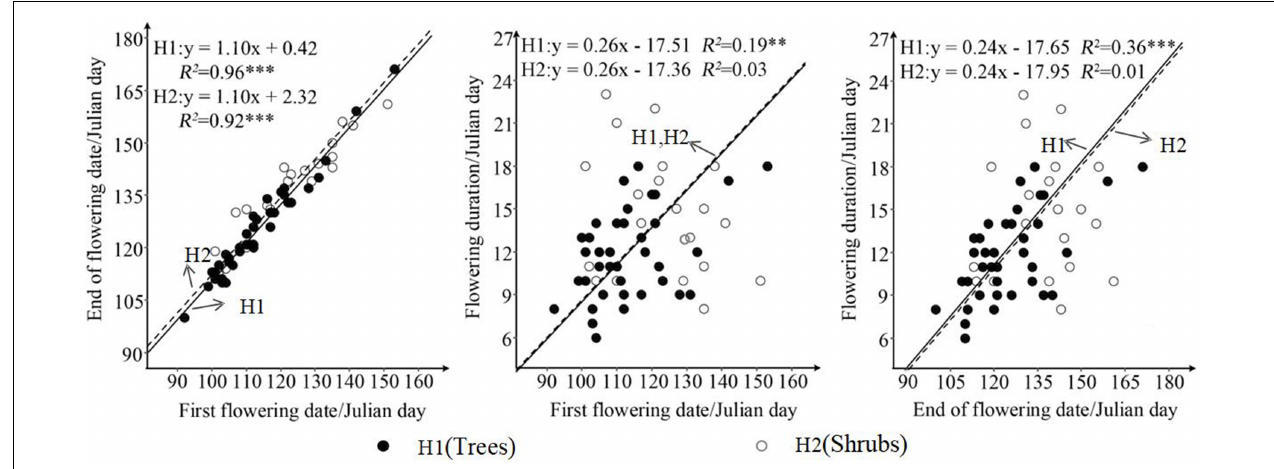
FIGURE 2 | Differences in relationship in terms of three characteristics of flowering phenology between trees and shrubs. H1 and H2 represent trees and shrubs, respectively. ∗∗∗ P < 0.001; ∗∗ P < 0.01.